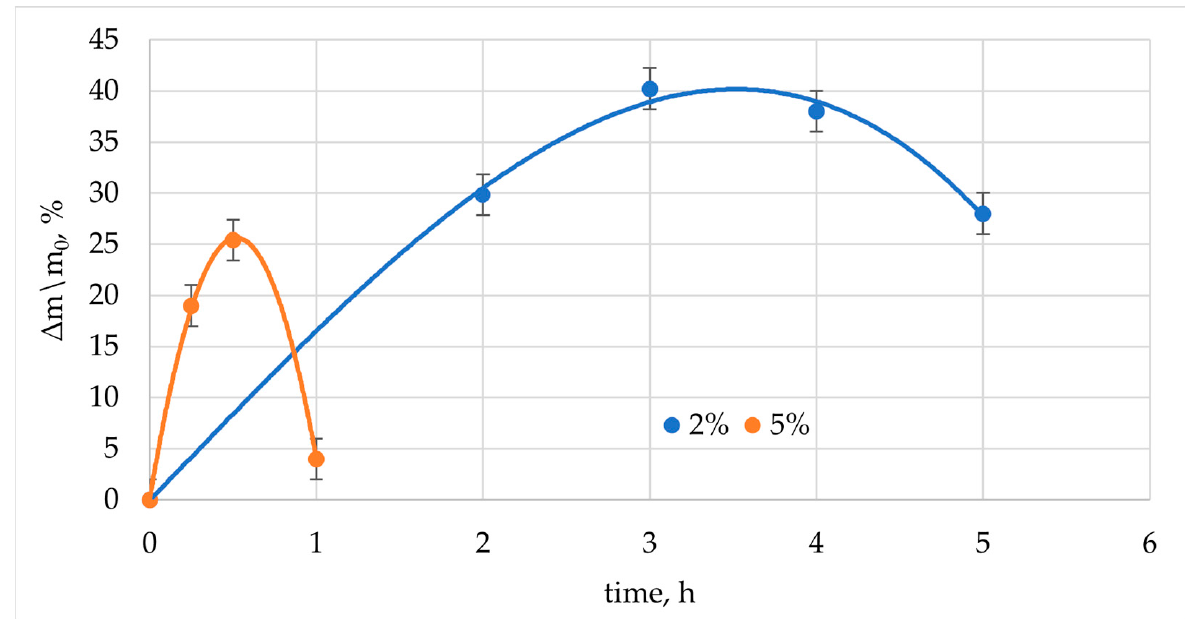
Figure 5. Curves of the relative mass ratio over time depending on the concentration of the complex (2,3,5-TPhTz) 2 [CuCl 4 ].